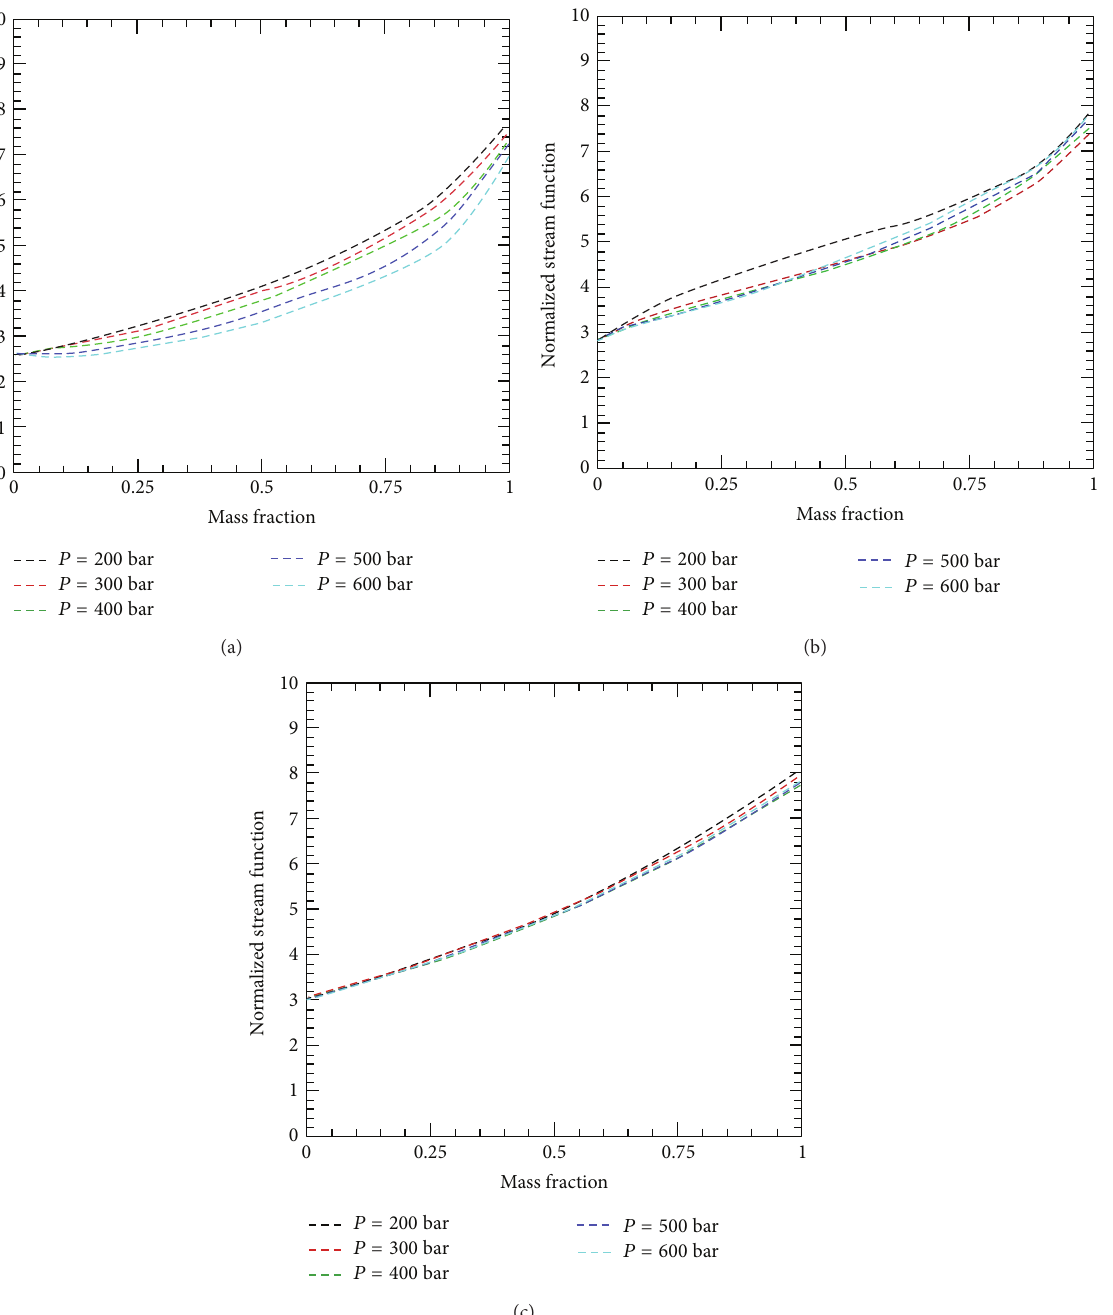
Figure 5: Dimensionless mass flow rate versus CO 2 mass fraction for different pressures and temperature combinations: (a) 𝑇 ℎ = 416 K; = 331 K, (b) 𝑇 = 466 K; 𝑇 = 381 K, and (c) 𝑇 𝑇 𝑐 ℎ 𝑐